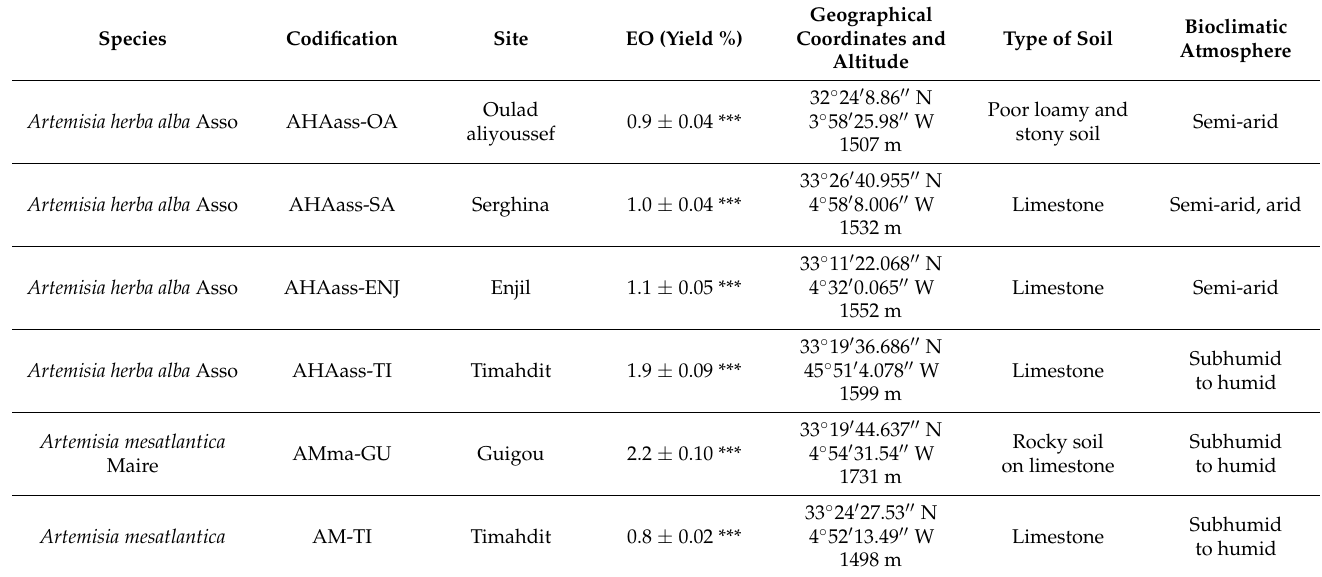
Table 1. Yield (%) in EO of the different species of sagebrush